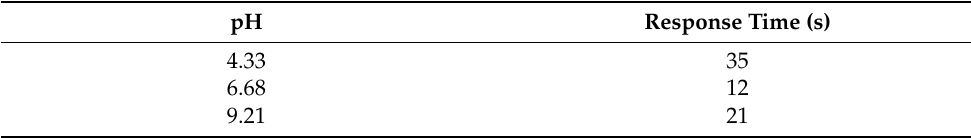
Table 3. TiN pH sensor response time for different pH solutions.